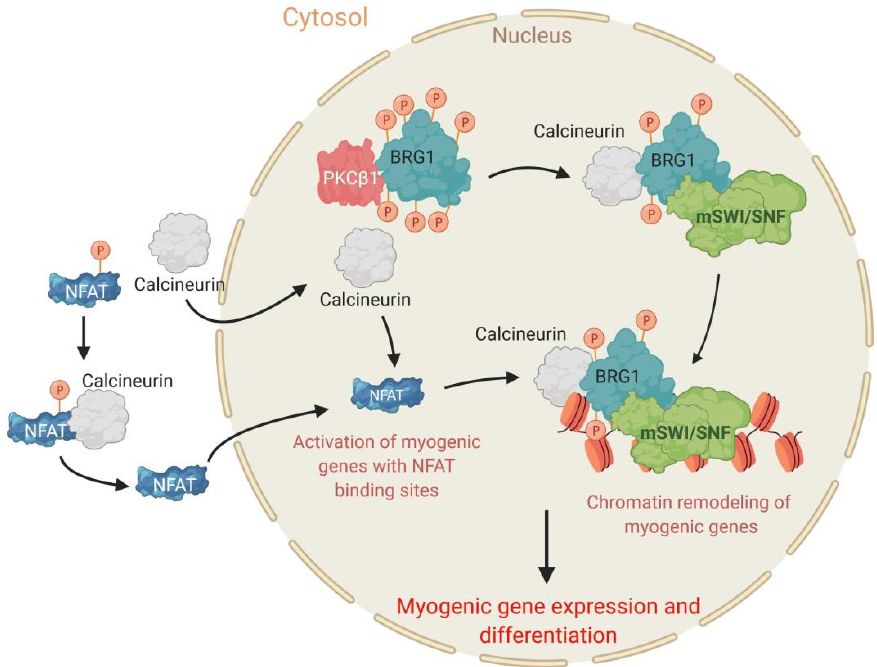
Figure 3. Antagonistic roles of PKCβ 1 and calcineurin in myogenesis. PKCβ 1 interacts with and phosphorylates BRG1 to block differentiation. Upon myogenic stimulus, calcineurin dephosphorylates BRG1 and the TF nuclear factor of activated T-cell (NFAT), enabling chromatin remodeling at myogenic loci, myogenic gene expression, and skeletal muscle differentiation.